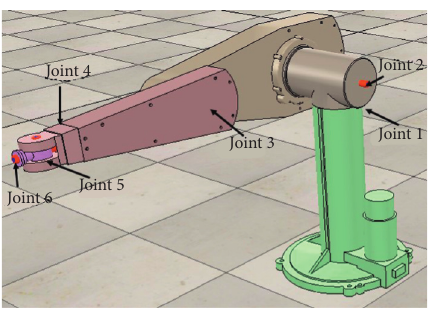
Figure 2: Photo of PUMA 560 with six